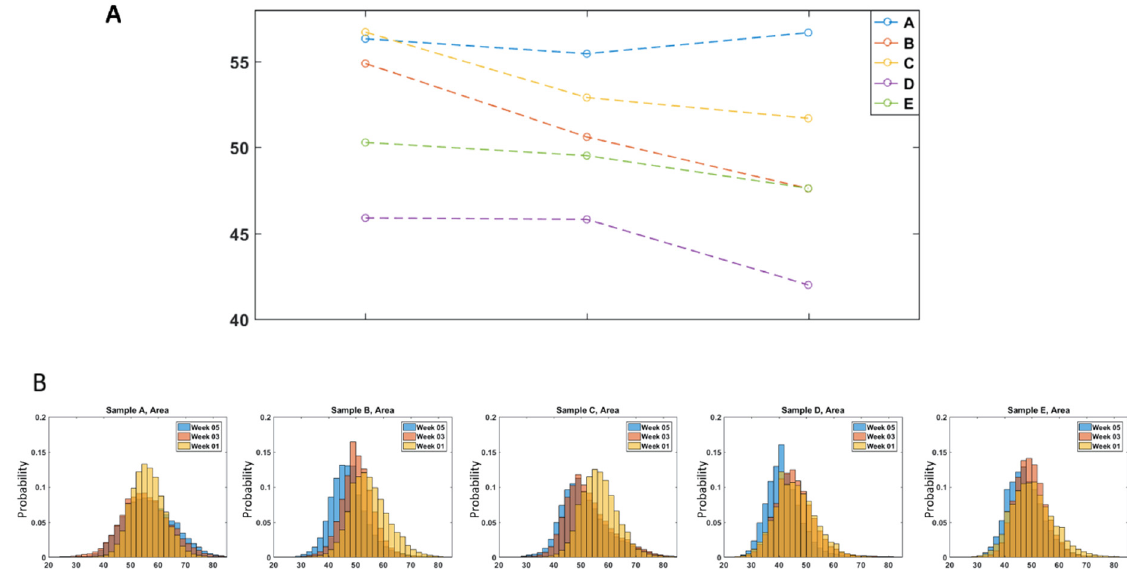
Figure 6. ( A ) Line plots of area for all samples over the storage time, ( B ) Normalized histogram of area of cells over the storage period for Sample A–E.